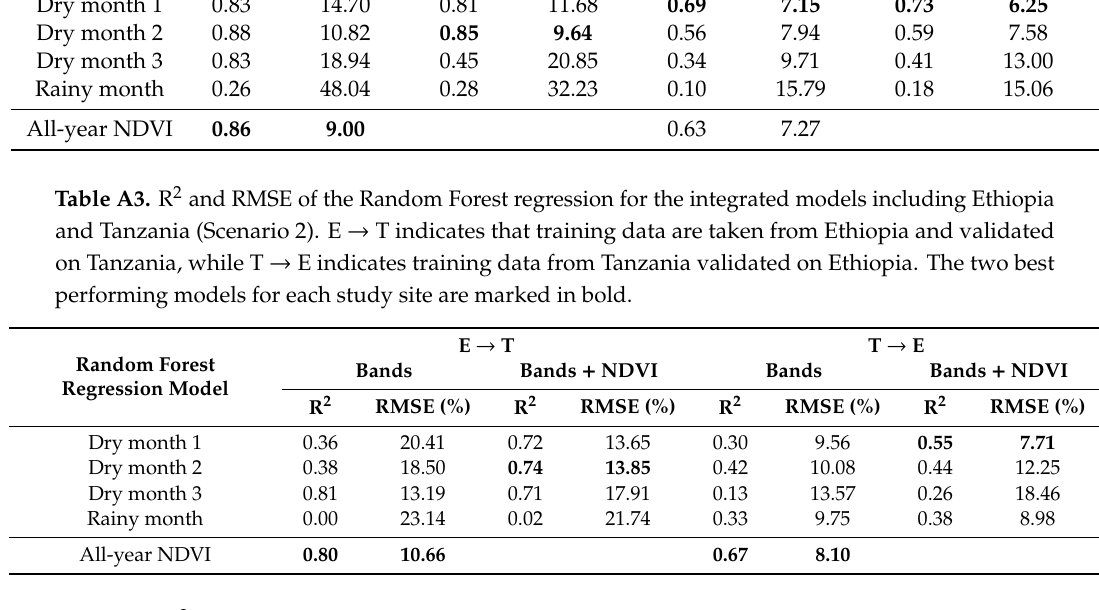
Table A4. R 2 and RMSE of the linear regression for the models combining Ethiopia and Tanzania (Scenario 3). The best performing model is marked in